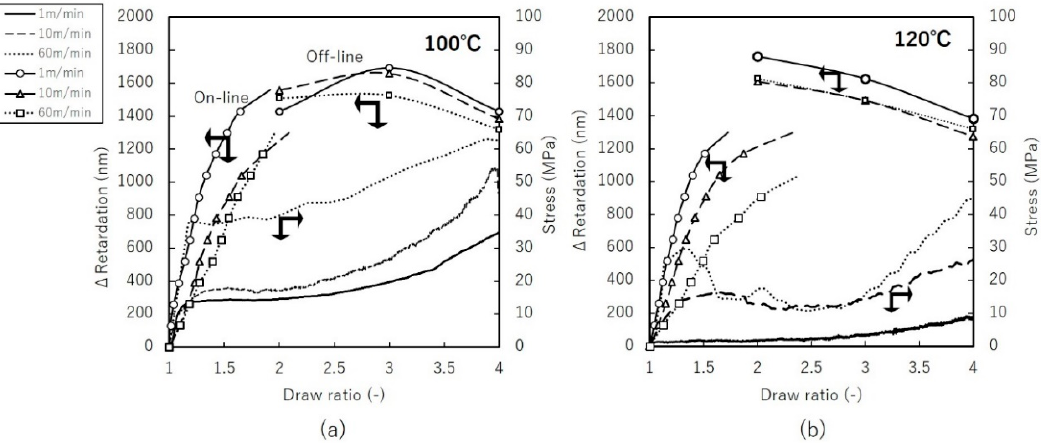
Figure 6. True stress and retardation vs. draw ratio of uniaxial constrained-width stretching at: ( a ) 100 °C ( b ) 120 °C.